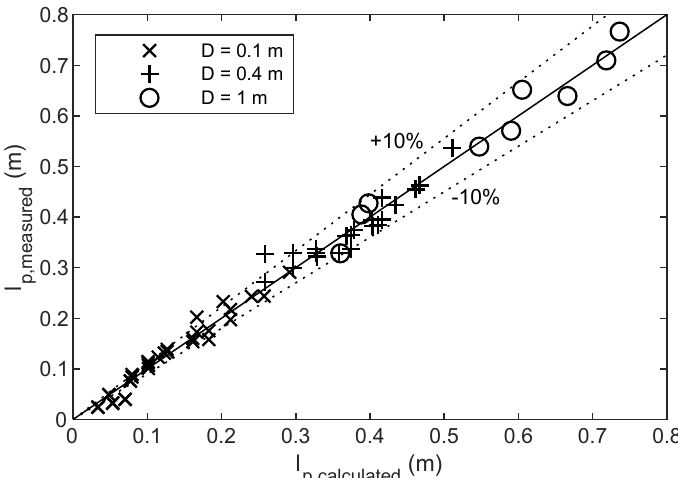
Figure 10. Parity plot of correlation prediction vs. experimental result of cross-sectional averaged mean pierced length for all plant diameters investigated.